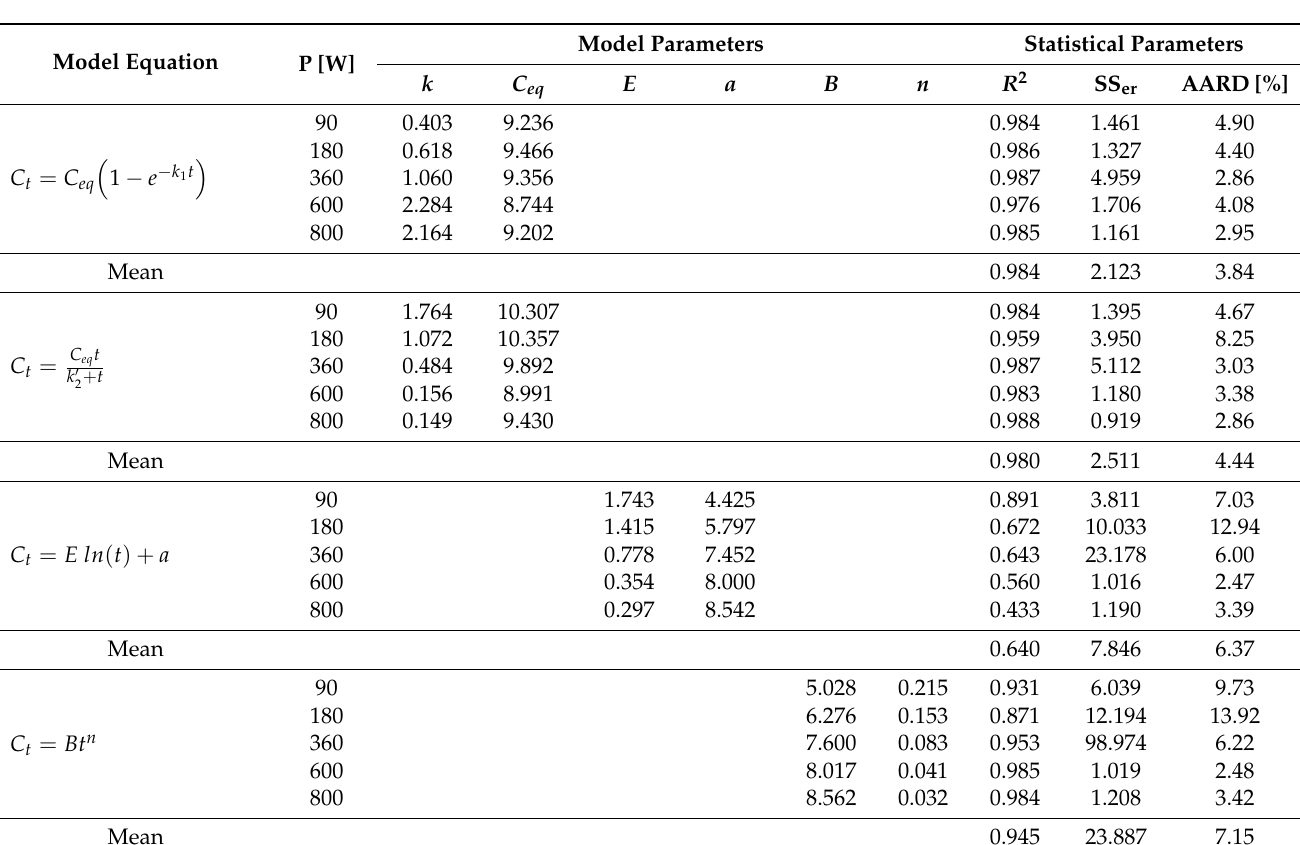
Table 2. Calculated parameters and statistical data of four empirical models applied for MAE kinetics of total phenols